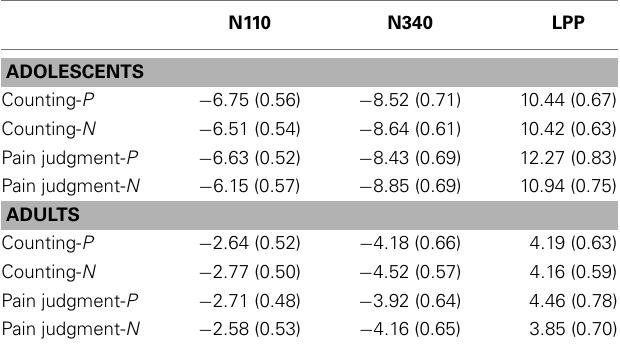
Table 3 | Mean amplitudes (SD) of the N110, N340, and LPP, in each experimental condition, for adolescents and